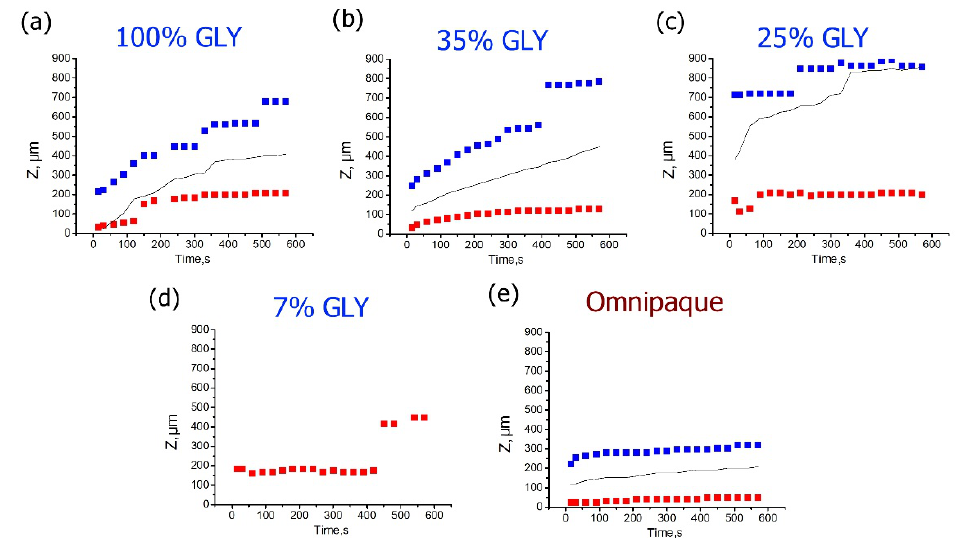
Figure 5. Time dependences for the depth positions of the cumulative strain minima (blue) and maxima (red) corresponding to various glycerol concentrations for 600 s observation time. ( a – d ) are for the glycerol solutions of 7%, 35%, 25%, and 100% ( w / w ), correspondingly, ( e ) is for Omnipaque. The data for the neutral line of zero strain are shown by solid black curve.